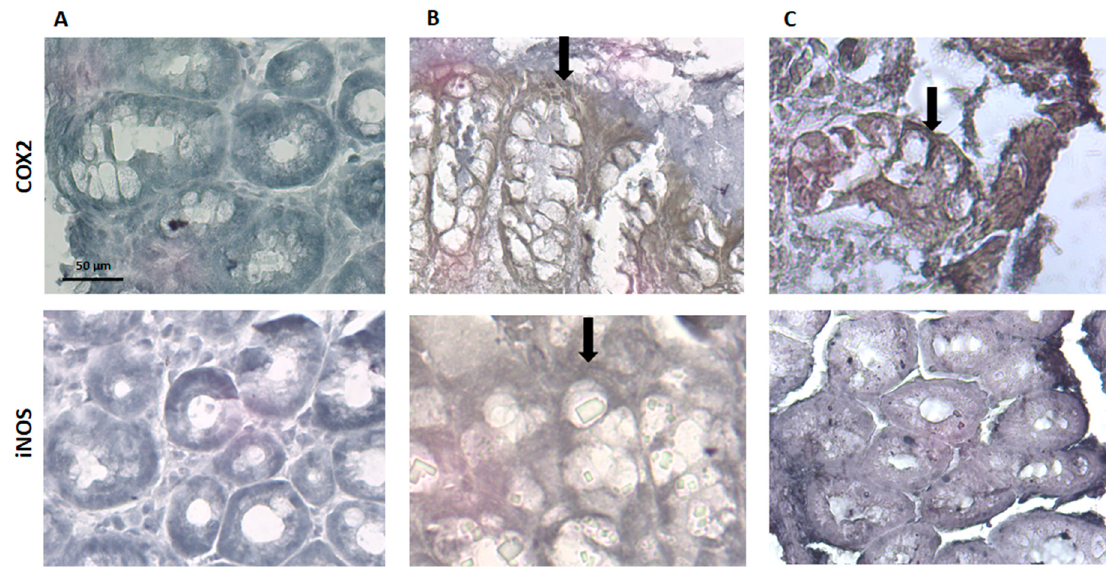
Figure 9. Effect of spearmint phenolic extract administration on the colon tissue expression of COX-2 and iNOS. The production of COX-2 and iNOS are exhibited by brown staining and arrows ( A ) Sham group, ( B ) TNBS group, ( C ) TNBS + spearmint group. Original magnification × 100. Scale bar equals 50 µm.